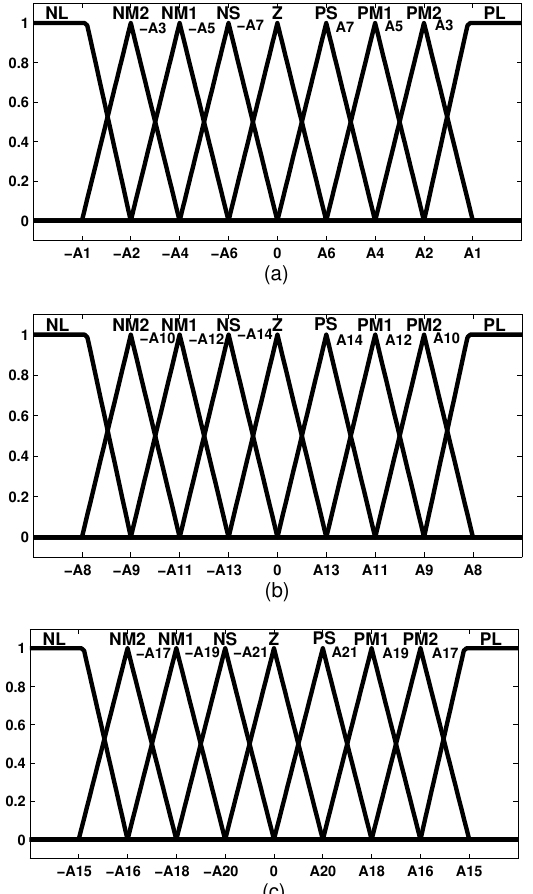
Figure 3. ( a ) Fuzzy membership functions for the governor controller’s first input; ( b ) Fuzzy membership functions for the governor controller’s second input; ( c ) Fuzzy membership functions for the governor controller’s output. NL: Negative Large; NM2: Negative Medium2; NM1: Negative Medium1; NS: Negative Small; Z: Zero; PS: Positive Small; PM1: Positive Medium1; PM2: Positive Medium2; PL: Positive